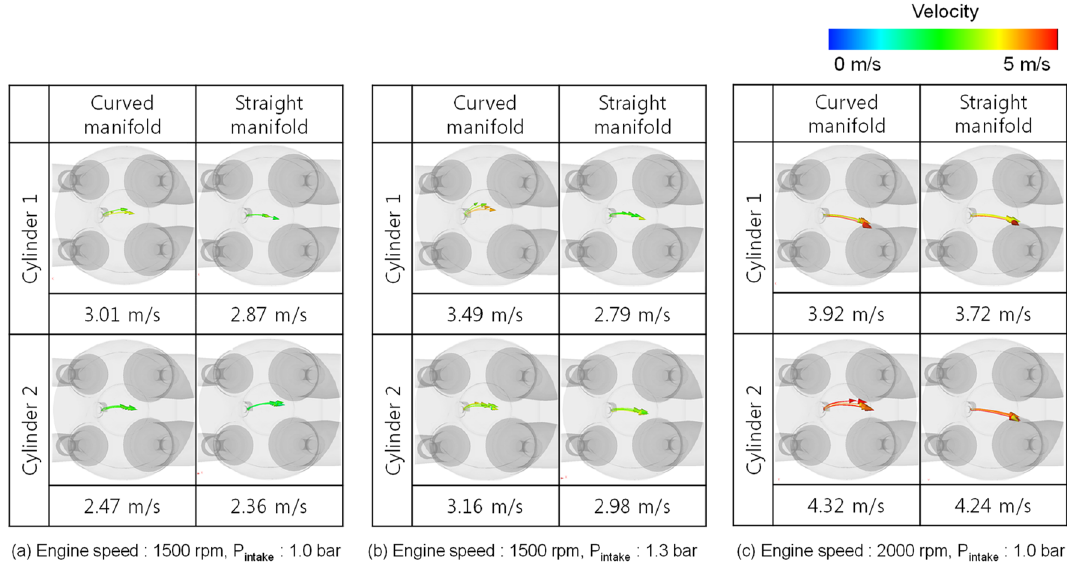
Figure 17. Comparison of spark plug gap velocity between cylinders at TDC. Curved manifold (m/s) Straight manifold